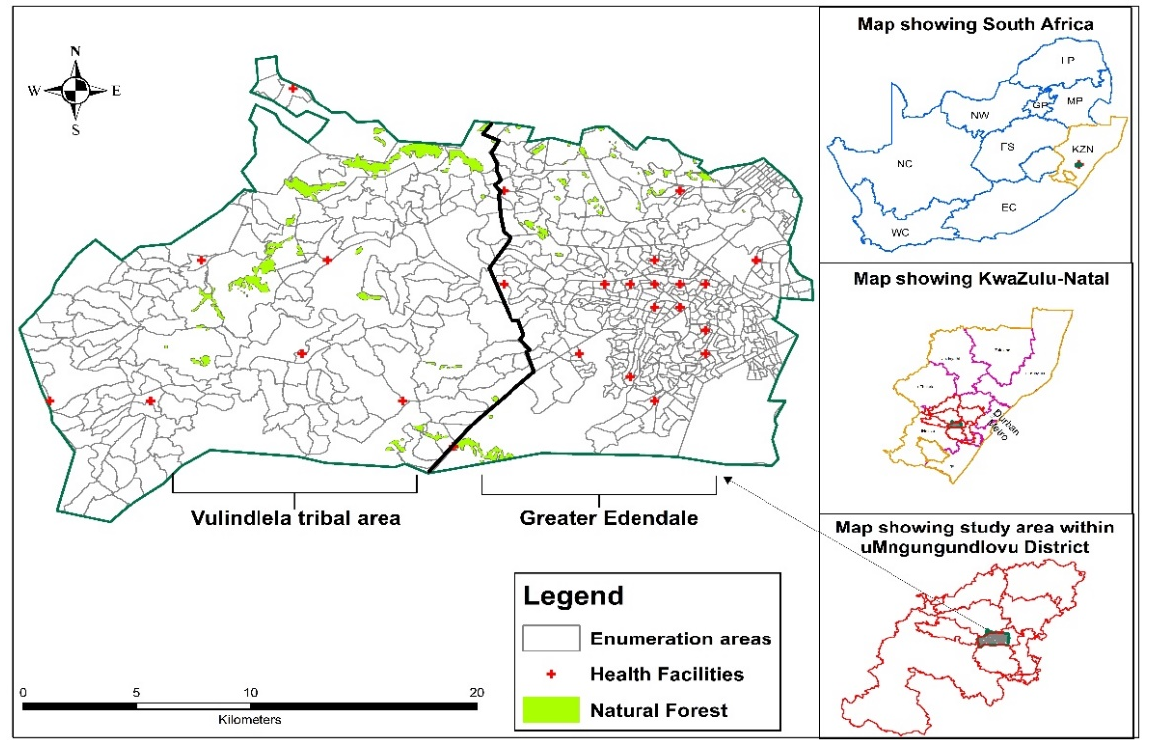
Figure 1. Location map of Vulindlela (rural) and Greater Edendale (peri-urban) area in the uMgun- gundlovu District, KwaZulu-Natal Province, South Africa.